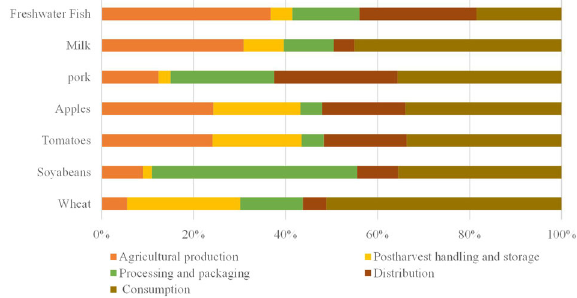
Fig. 3 Average waste by stage for seven food categories in China from 2010 to 2019. The percentage amount of food waste at fi ve stages (labels on the bottom) in the food supply chain of each food category (labels on the left) in China. Data are annual averages for the period 2010 – 2019. Table 2. Utilization rates for seven food categories in China from 2010 to 2019. Food